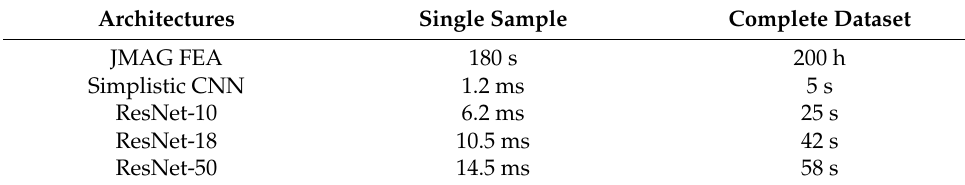
Table 5. Analysis time of FEA and different CNN